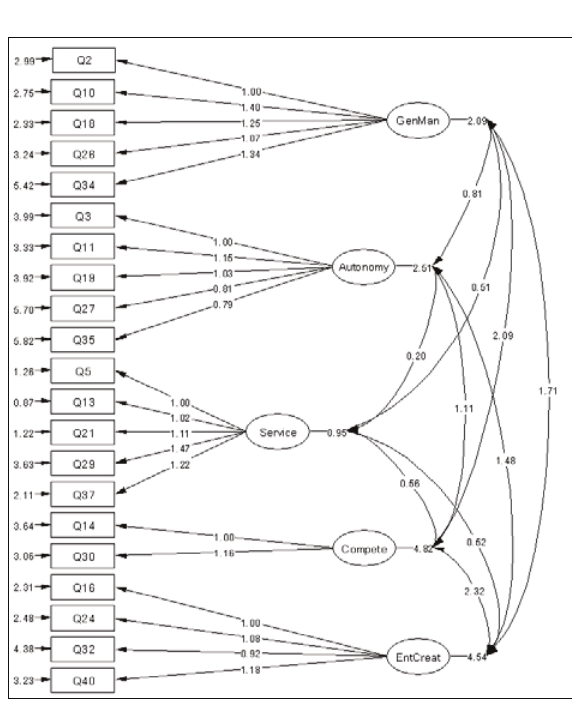
FIGUrE 1 Standardised parameter estimates for five-factor COI model (single